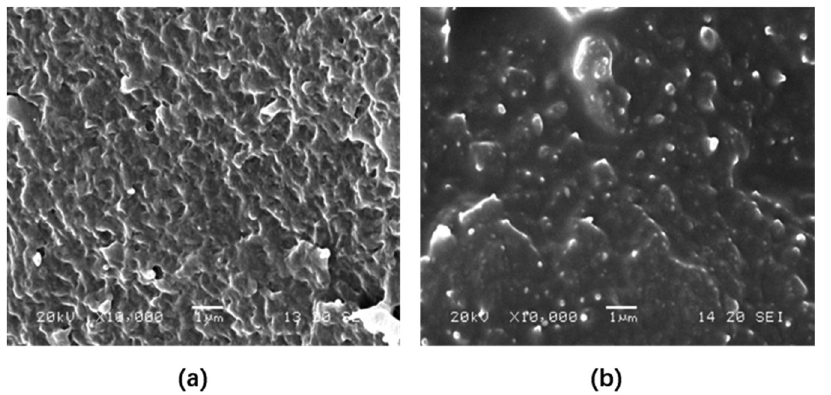
Figure 7: SEM photographs of the impact fracture of the pure PEEK ( a ) and HA/PEEK nanocomposite ( 2.5 wt% - modi fi ed HA ) ( b )